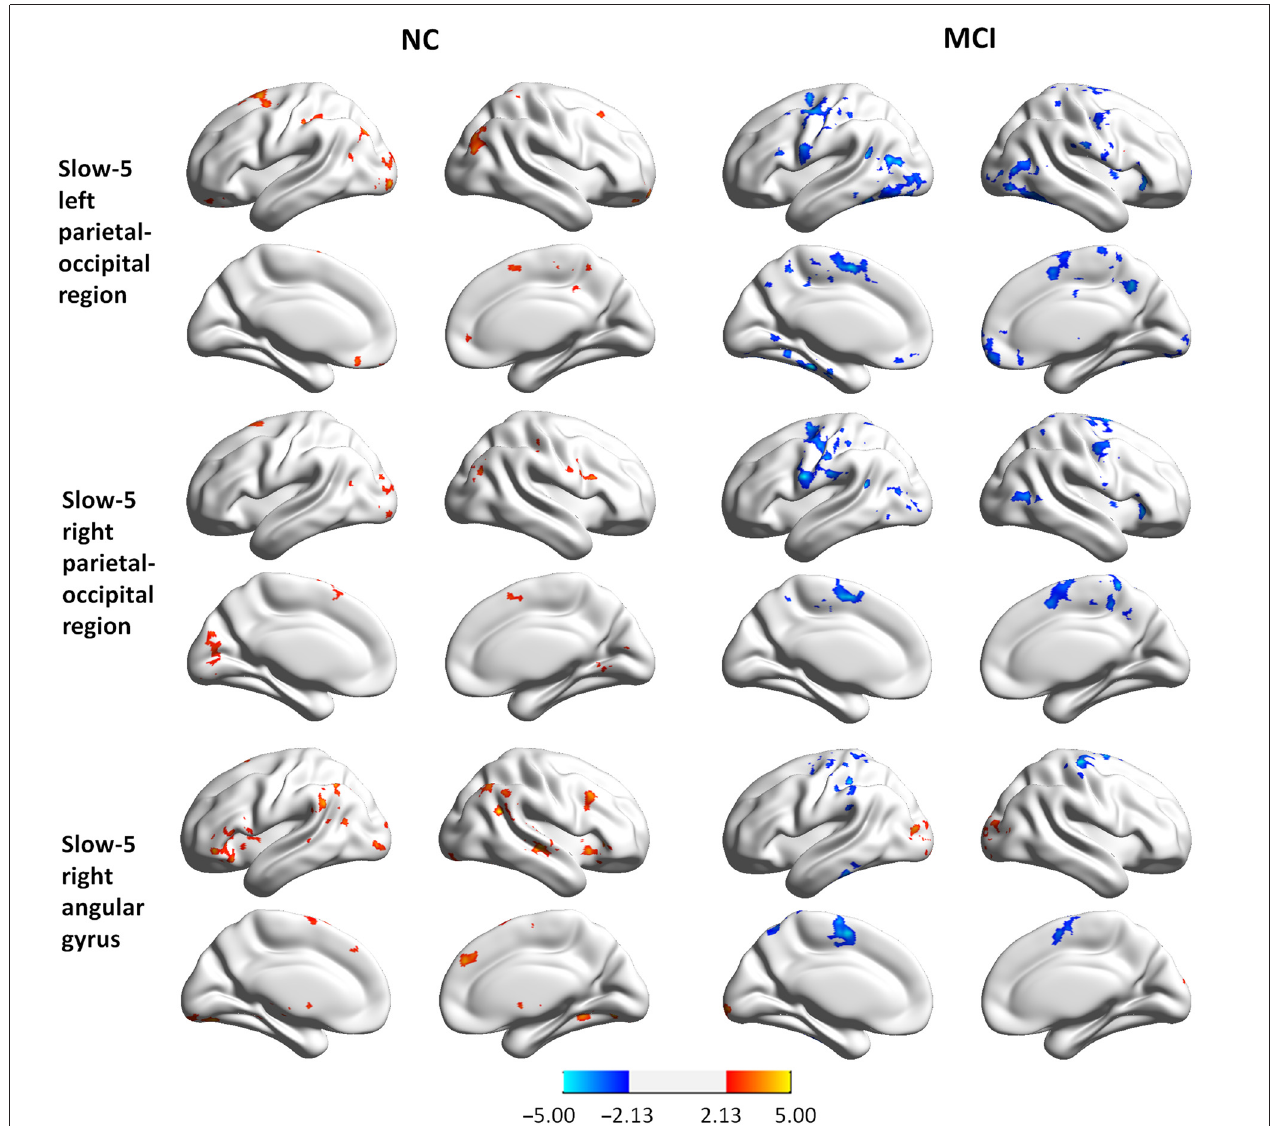
FIGURE 5 | Group differences in seed-based connectivity maps in resting and task states for three clusters showing group × state interactions: the left parietal-occipital regions, the right parietal-occipital regions, and the right angular gyrus in